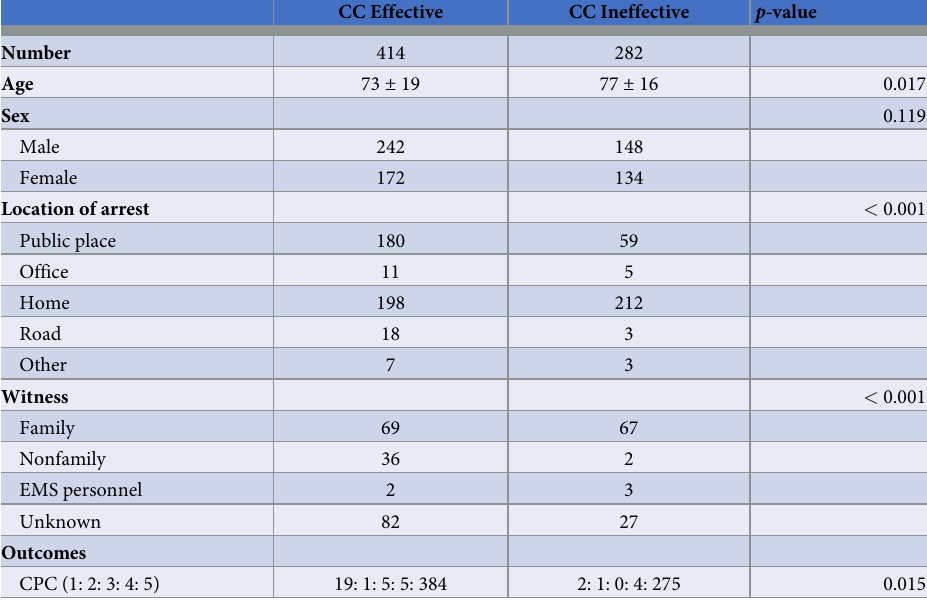
Table 5. Quality of chest compression at 1-month neurological